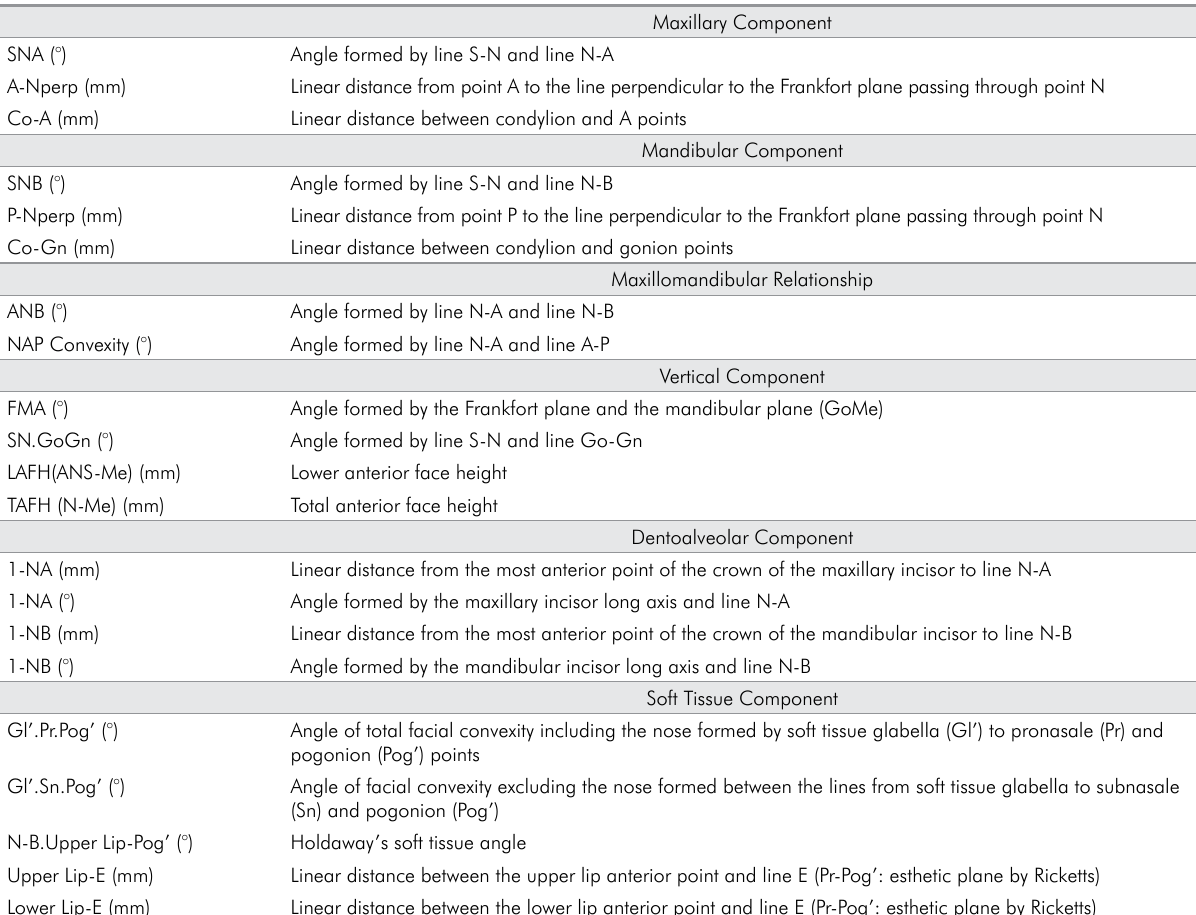
Table 1. Cephalometric variables assessed.